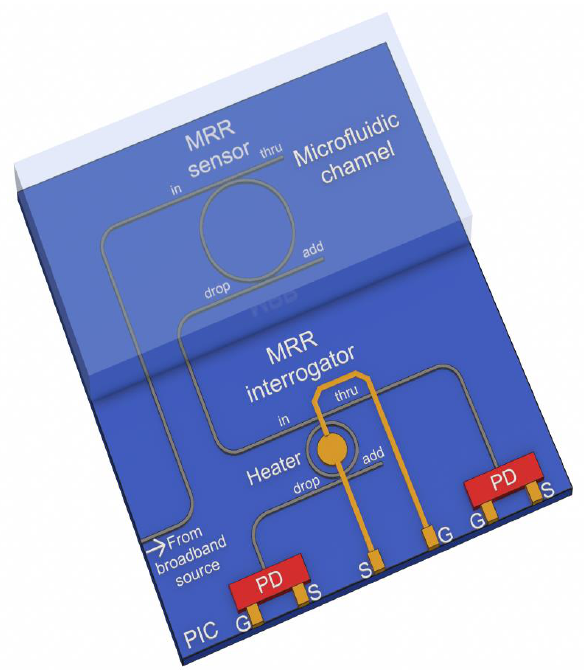
Figure 1. 3D design draft of the proposed integrated MRR-based sensing system with a broadband source (not to scale).